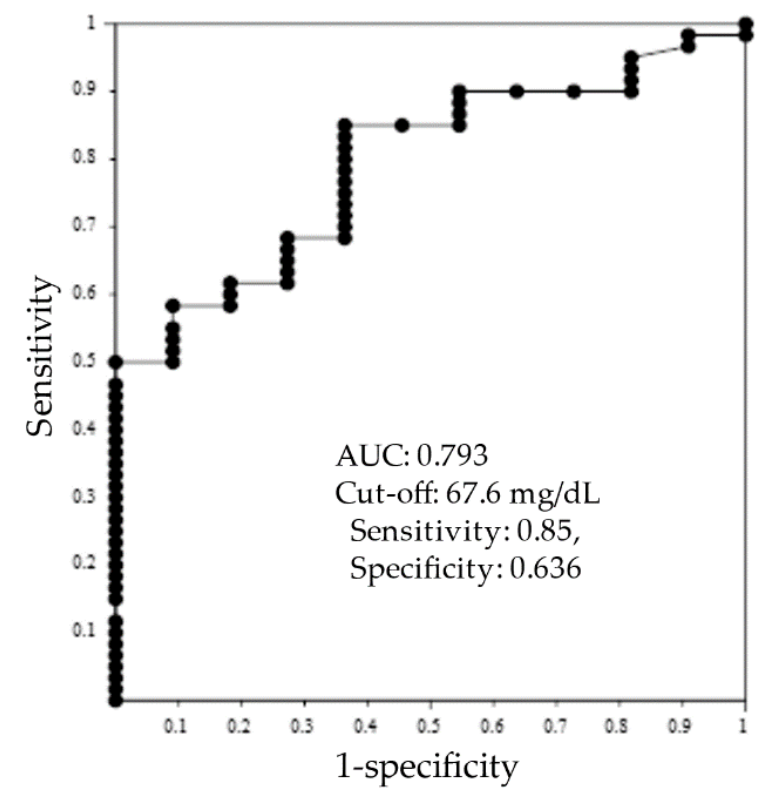
Figure 3. Receiver operating characteristic (ROC) curve analysis of IgG4levels. The area under the ROC curve and cut-off value were calculated using responder group ( n = 60) and nonresponder group (n = 11) data. AUC, area under the curve. Table 3. Contents of glucocorticoid